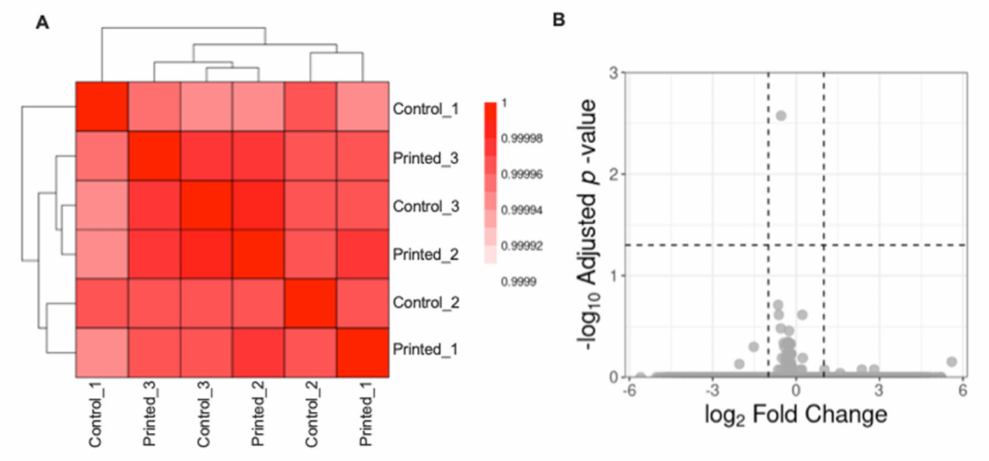
Figure 5. Printed nociceptor neurons transcriptome. Clustering of the samples showing the Pearson correlation value between each pair of samples ( A ). Volcano plot representation of differentially expressed genes between Control and Printed neurons ( B